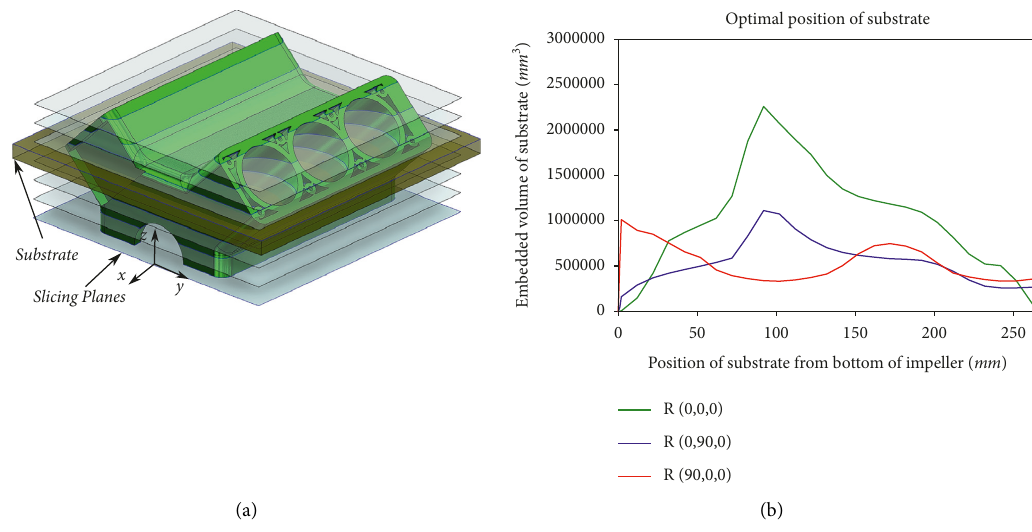
Figure 10: Illustrative example 3: (a) CAD model and (b) VI for different positions of the substrate with different orientations.